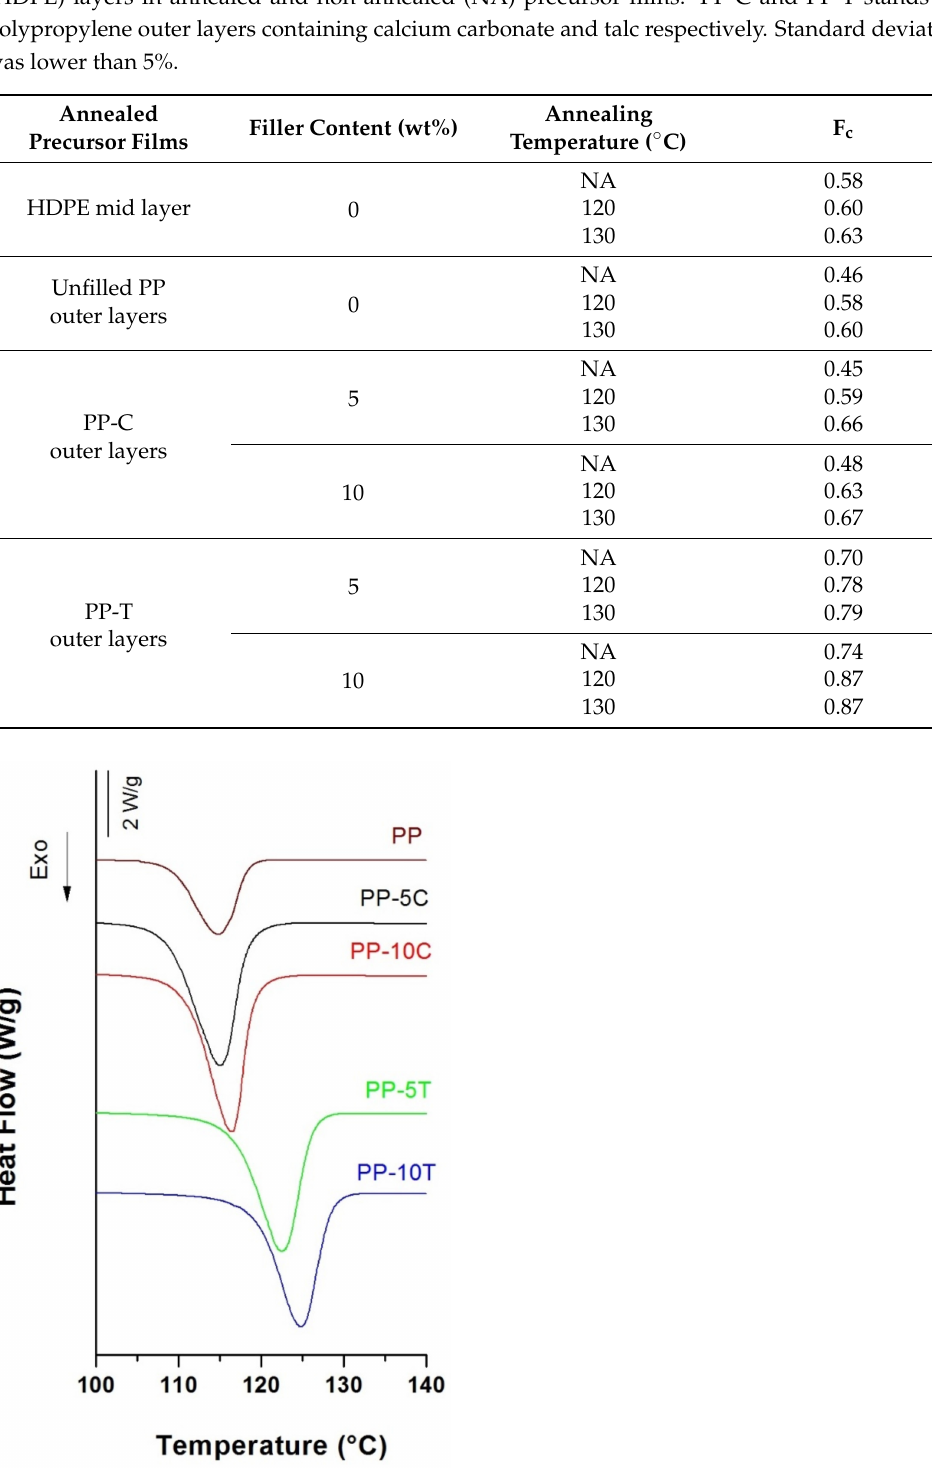
Figure 1. Crystallization exotherms obtained from pellets of neat polypropylene (PP), polypropylene filled with 5 wt% (PP-5C) and 10 wt% (PP-10C) CaCO 3 , polypropylene filled with 5 wt% (PP-5T) and 10 wt% (PP-10T)